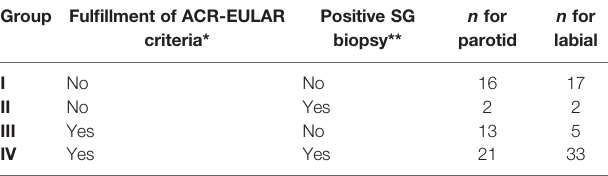
TABLE 2 | De fi nition of subgroups based on histopathological phenotype. Group Ful fi llment of ACR-EULAR criteria*